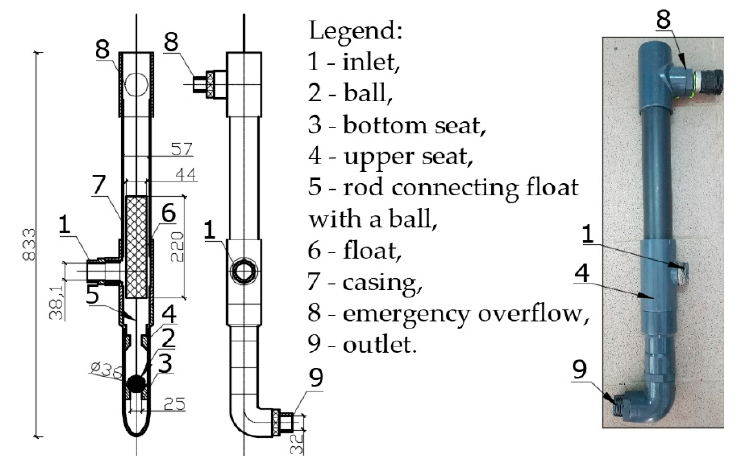
Figure 6. Vertical section and side view of the check valve at the ST outlet.